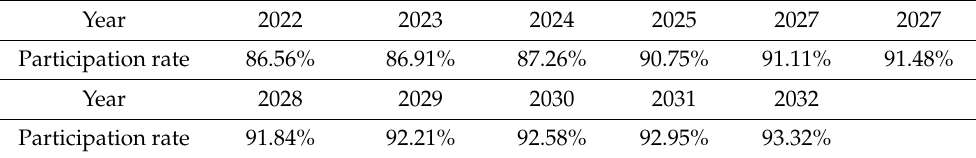
Table 3. Assumptions of the basic pension participation rate of enterprise employees from 2022 to 2032.